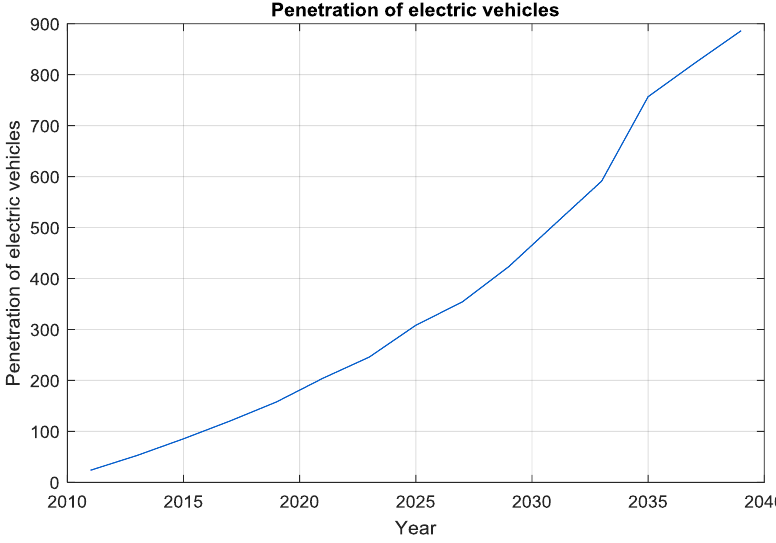
Figure 7. Penetration of electric vehicles.